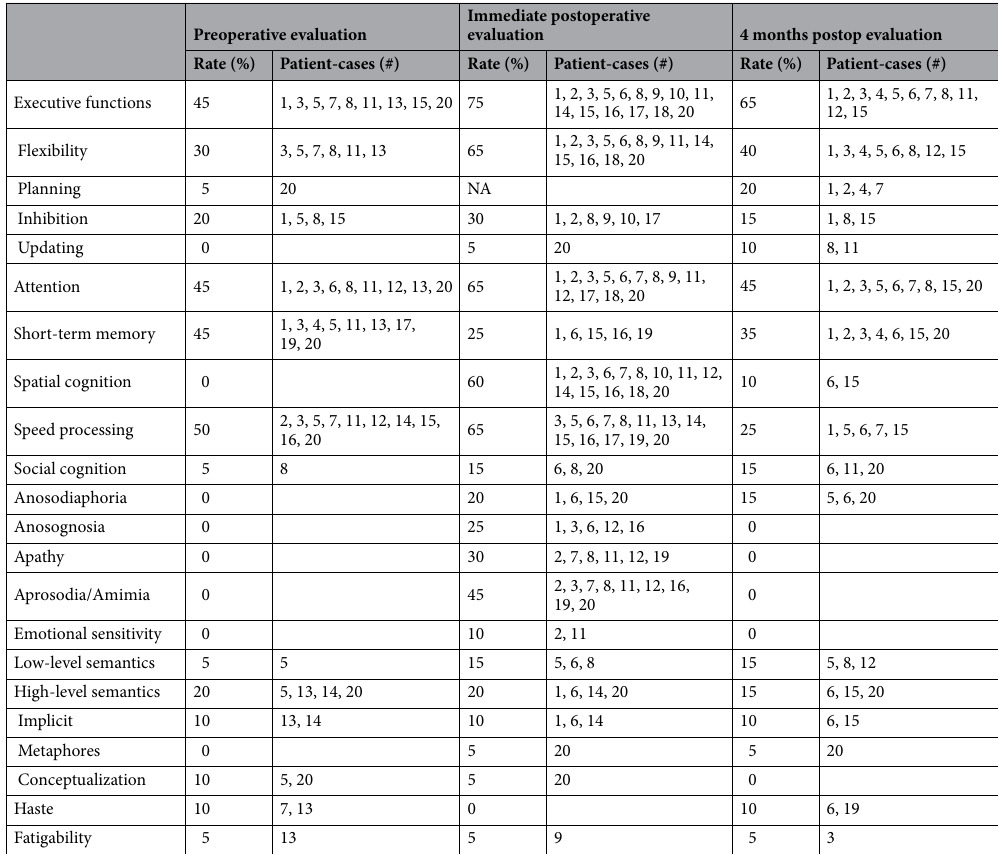
Table 5. Objective neuropsychological